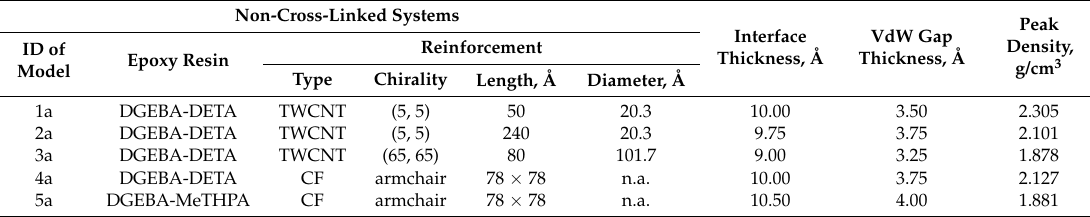
Table 2. Structural characterization of interface region in non-cross-linked epoxy resin nanocomposites.